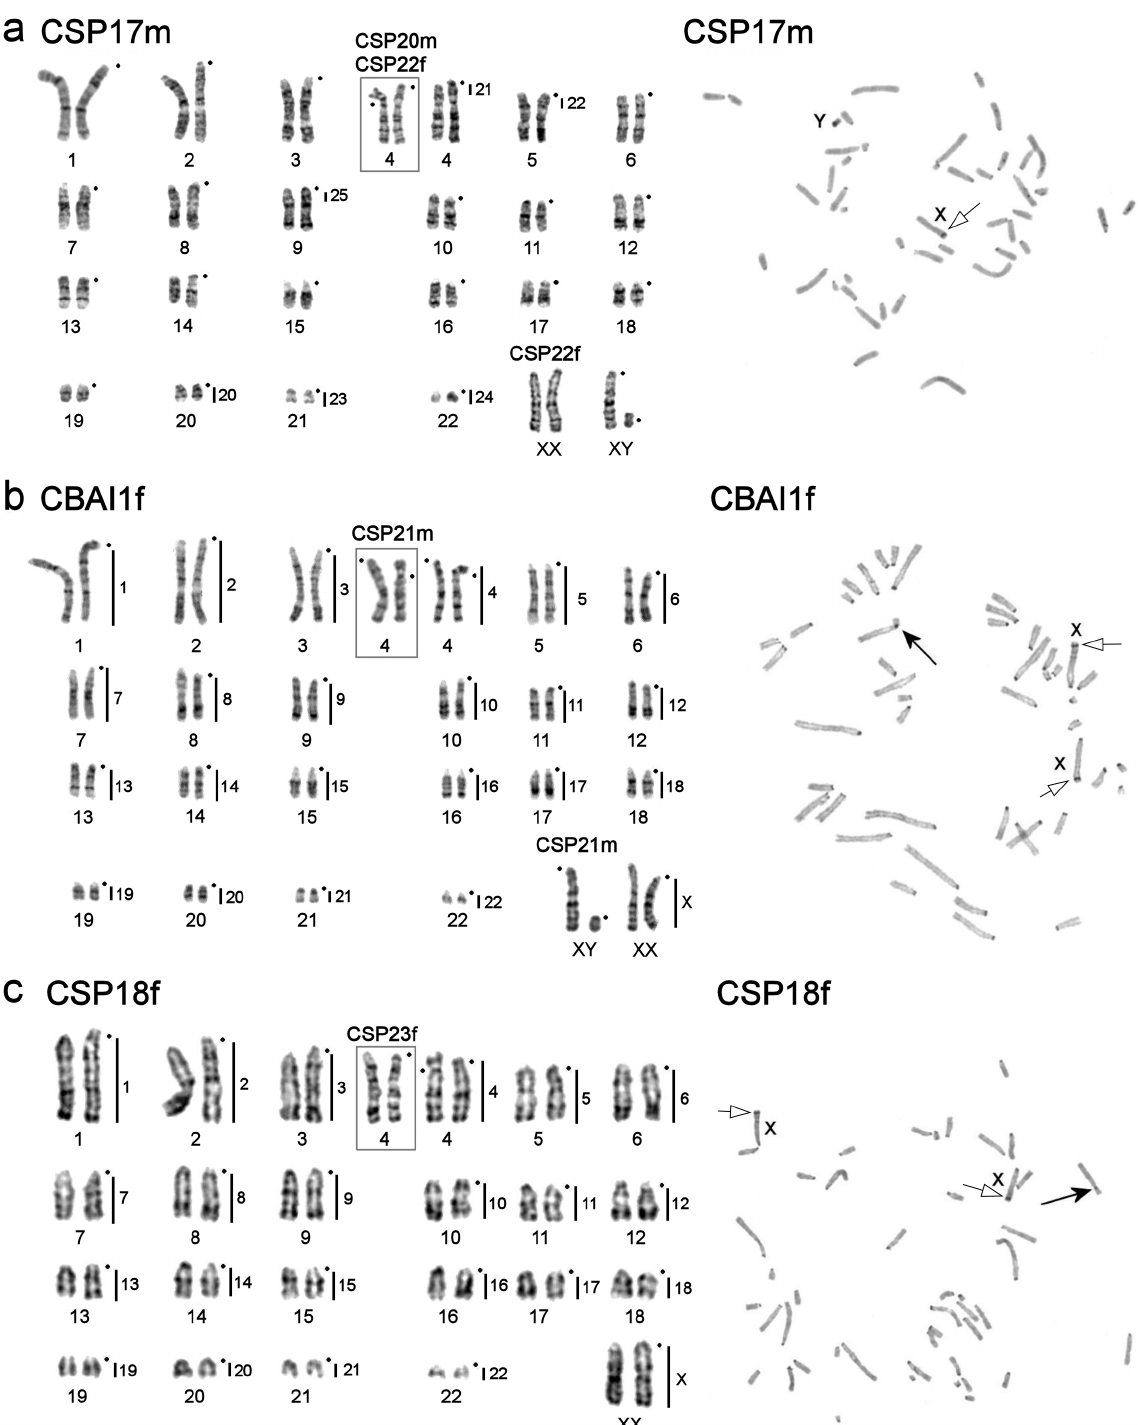
Figure 3. G-banded karyotypes (on the left) and C-banded metaphases (on the right) of the studied specimens with 2n = 46 and FNa = 44–45: ( a ) Calomyscus sp. 17m, Calomyscus sp. 20m (CSP20m), and Calomyscus sp. 22f (CSP22f), vertical black lines and figures on the right of G-banded chromosomes show localization of CSP3m probes; ( b ) C. bailwardi (the karyotype was presented previously in [44]) and Calomyscus sp. 21m (CSP21m); ( c ) Calomyscus sp. 18f and Calomyscus sp. 23f (CSP23f). In part b and c vertical black lines and figures on the right of G-banded chromosomes show localization of CSP17m probes. Black dots mark the position of centromeres. In C-banding photos the black arrows mark the submetacentric homolog of chromosome 4 and sex chromosomes (X and Y) are shown. The white arrows with black stroke mark the interstitial heterochromatic block in the distal region of X